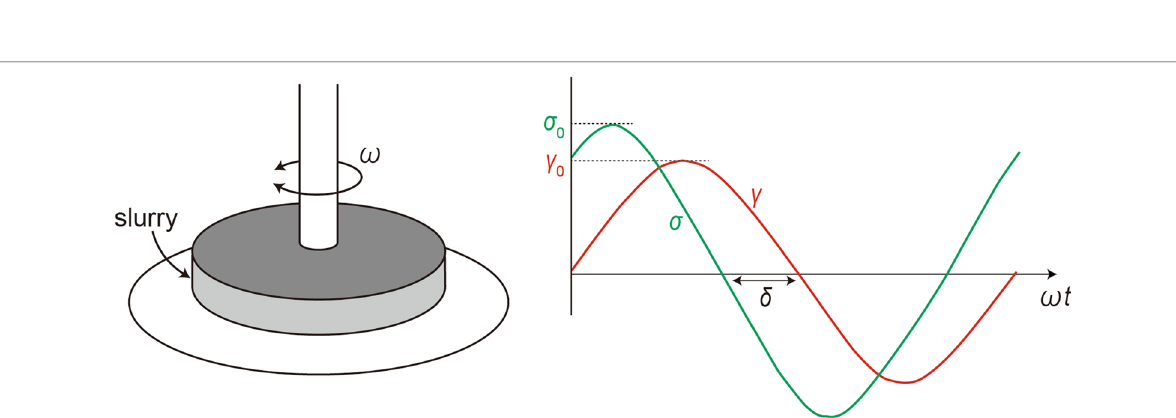
Fig. 2 Schematic image of vane measurement (left) and example measurement results for slurry made of dried soil (solid volumetric fraction φ 0.201; right). The vane spindle was rotated at 0.4 rpm during measurement =